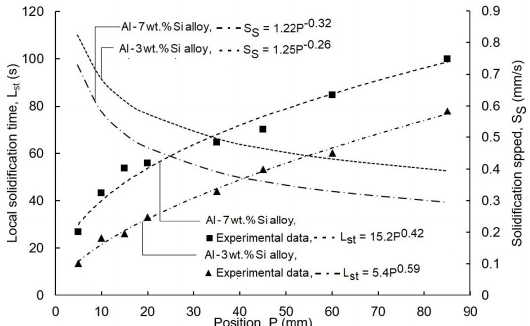
) and solidification speed st